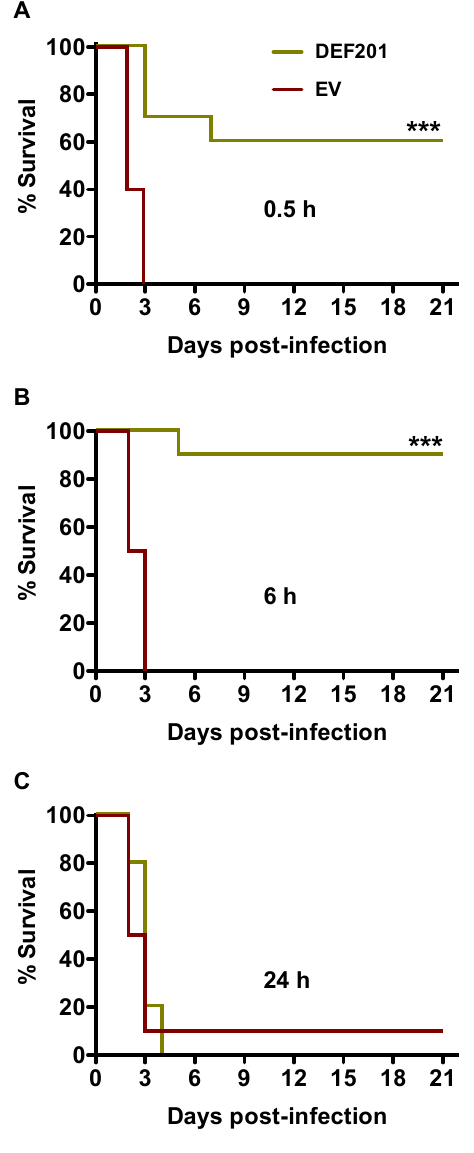
Figure 4. Post-exposure treatment with DEF201 protects hamsters from lethal s.c. RVFV infection. Hamsters (n = 10 per group) were treated with 10 8 PFU of DEF201 or EV at ( A ) 0.5 h, ( B ) 6 h, or ( C ) 24 h post-infection with 30 PFU of RVFV.